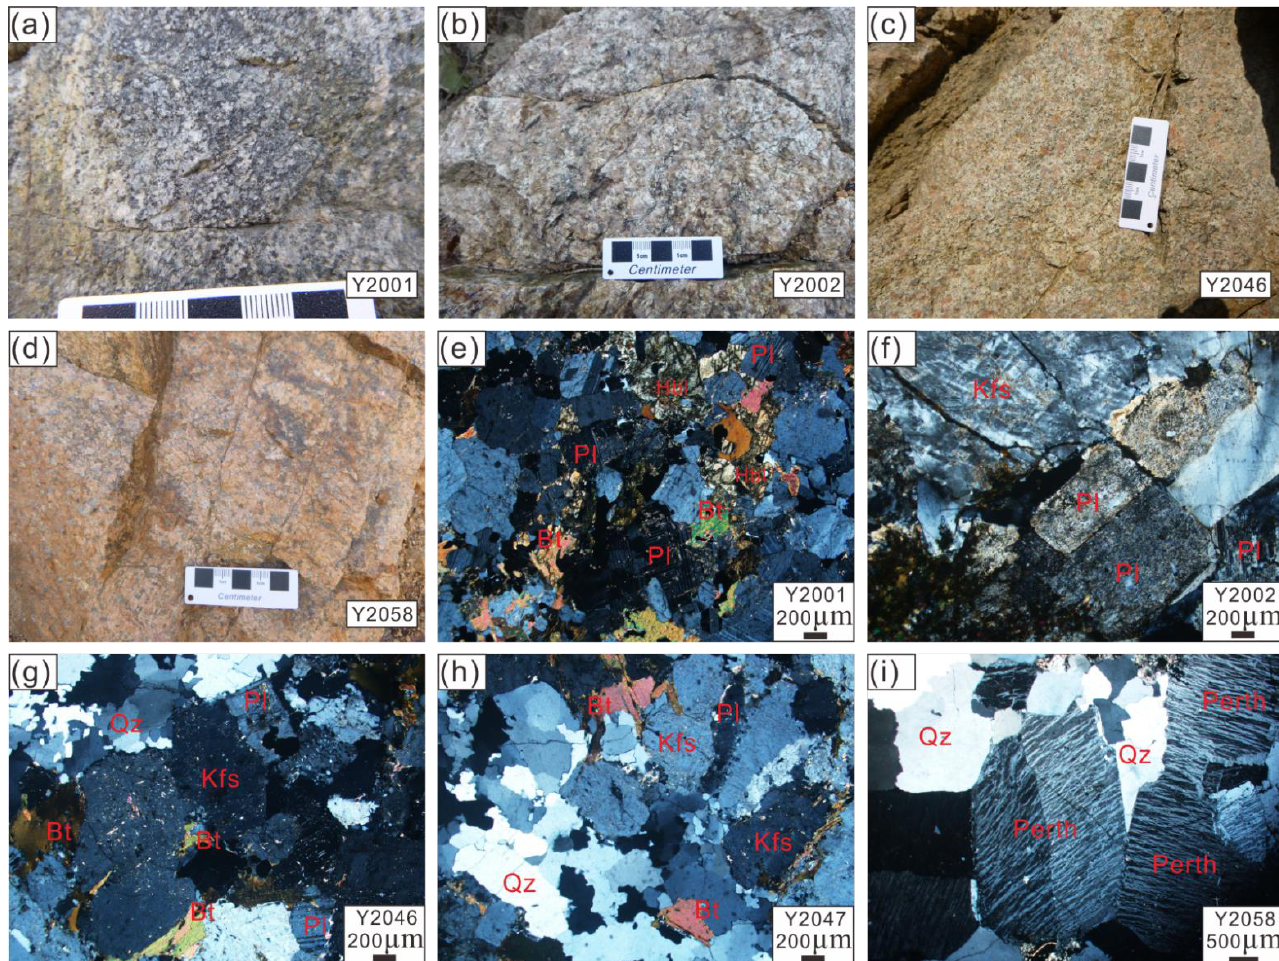
Figure 4. Field photographs ( a – d ) and photomicrographs ( e – i ) showing typical features of the analyzed samples. ( a ) quartz diorite (Y2001); ( b ) monzogranite (Y2002); ( c ) granite (Y2046) and ( d ) syenogranite (Y2058). ( e – i ) cross polarized light. Kfs: K-feldspar; Pl: plagioclase; Qz: quartz; Bt: biotite; Hbl: hornblende; Perth: perthite.